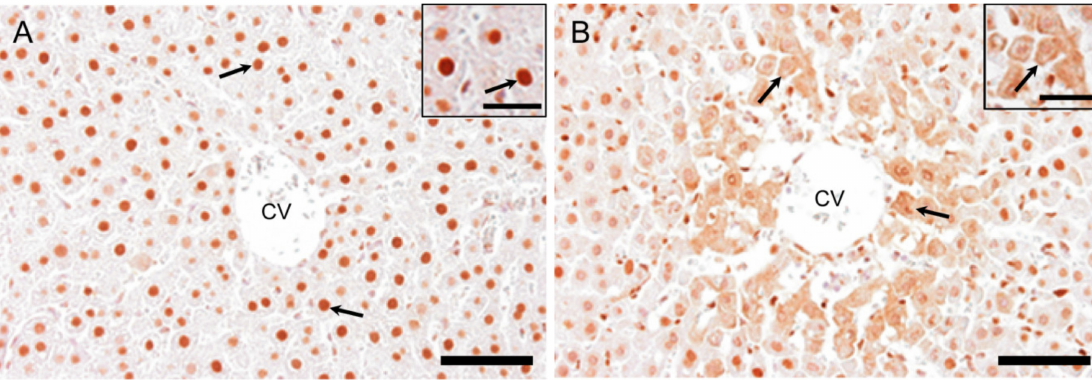
Figure 10. Immunohistochemistry for HMGB1 in APAP-induced rat hepatotoxicity. Nuclei of hepatocytes in the controls are positive for HMGB1 (arrows) at basal level ( A ). Hepatocytes in the a ff ected centrilobular area faintly show cytoplasmic positivity (arrows) with decreased nuclear staining for HMGB1 on day 1 ( B ). Insets are higher magnifications. Immunohistochemical staining. CV, central vein; HMGB1, high mobility group box1. Bar = 50 µ m, inset bar = 20 µ m.